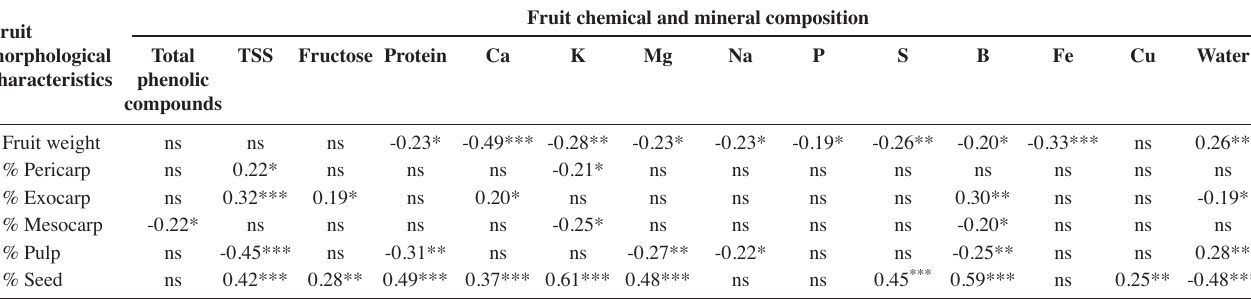
Tab. 4: Pearson correlation coefficients between fruit morphological characteristics and fruit chemical and mineral composition from 105 guava trees summa- rized for all the regions Fruit chemical and mineral